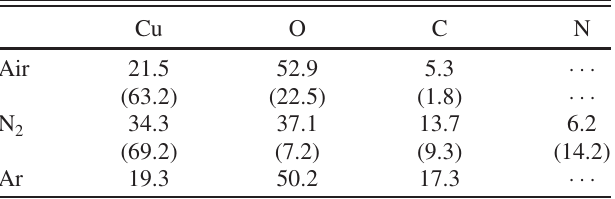
TABLE I. Surface composition (in at. %) based on a quanti- tative XPS analysis for Cu surfaces after laser treatment in different atmospheres. The numbers are given for samples measured as prepared after transport and insertion into the analysis system, while the values in brackets are determined after UHVannealing of the samples that had been laser treated in air or N 2 , respectively.